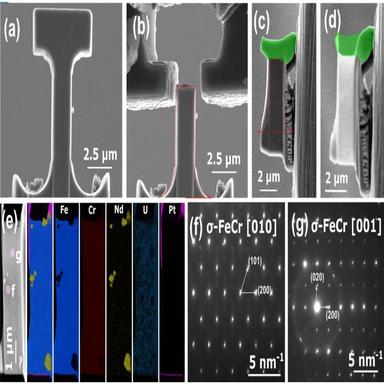
TEM characterization results for the FCCI_007 specimen. SEM images before (a) and after (b) testing and during TEM foil preparation in FIB/SEM (c) and (d), in which the deposited Pt deposition was highlighted in green color. (e) STEM HAADF image and the STEM-EDS mapping of the representative elements. (f) and (g) are diffraction patterns of two selected areas as marked in (e).